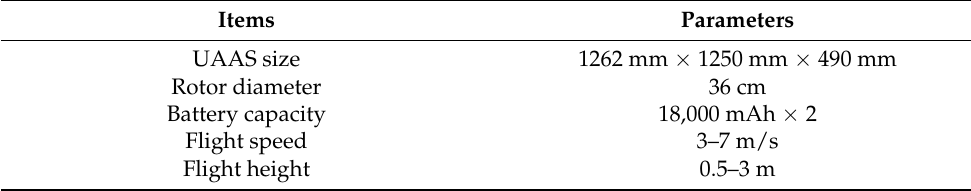
Table 2. The main technical parameters of